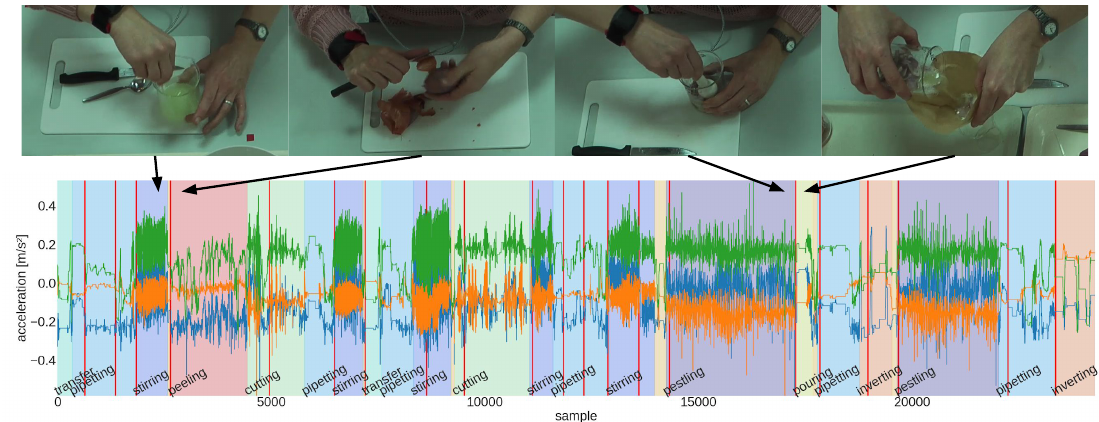
Figure 1. An example of the clustering result for one DNA extraction experiment. Shown are the acceleration time series (orange, blue, green), ground truth labels (background colors) and transitions found from clustering (red vertical bars). Additionally, some video stills at the top show the process at different moments in time (arrows; l.t.r. : stirring, peeling, pestling, pouring). The cut marks are extracted from wrist acceleration